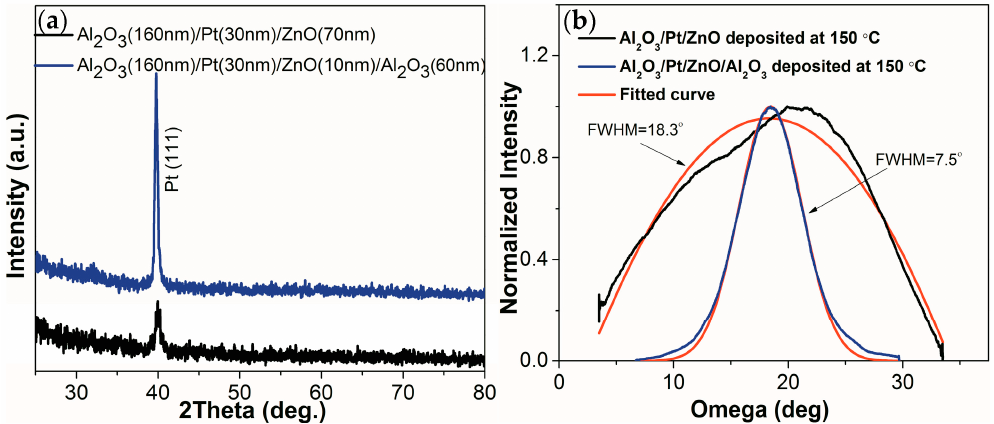
Figure 4. ( a ) θ –2 θ XRD (X-ray diffraction) scans of the Al 2 O 3 /Pt/ZnO/Al 2 O 3 /LGS and Al 2 O 3 /Pt/ZnO/LGS samples; ( b ) Omega XRD scans of the Al 2 O 3 /Pt/ZnO/Al 2 O 3 /LGS and Al 2 O 3 /Pt/ZnO/LGS samples.